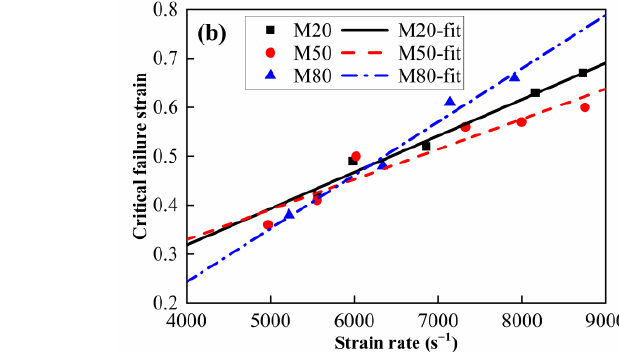
Table 5. Johnson–Cook constitutive parameters of the